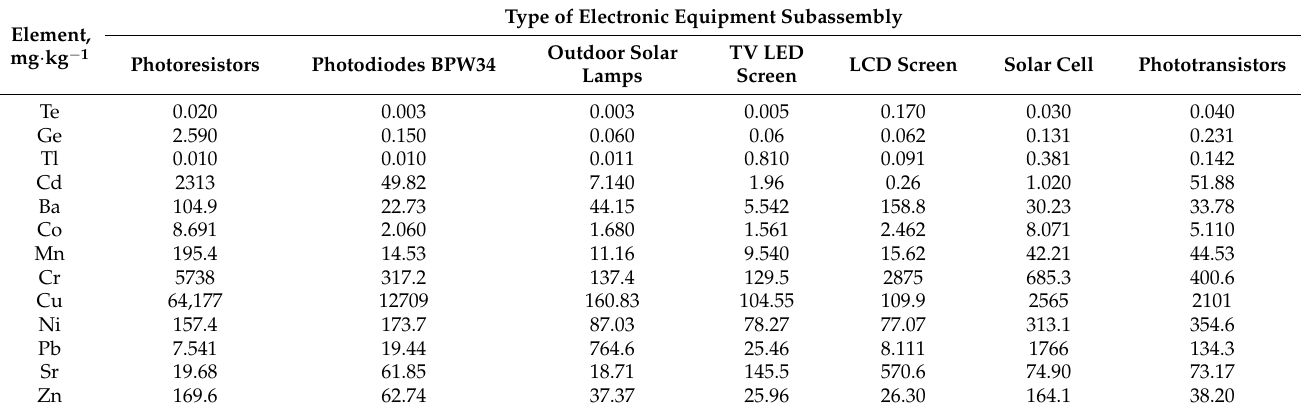
Table 6. Average content of metals in components and sub-assemblies of electronic